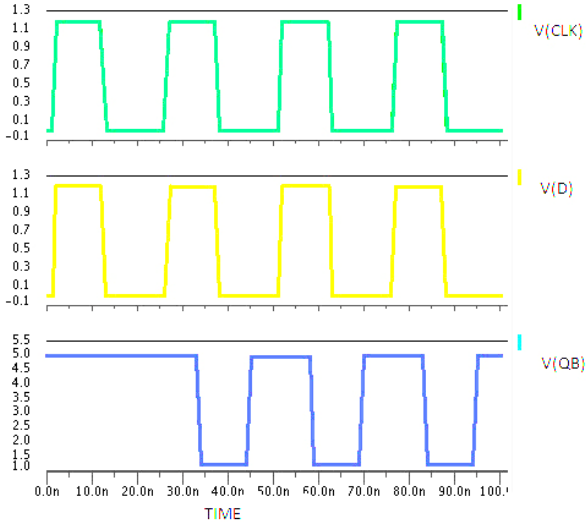
Figure 14. The simulation results of the SISO shift register.